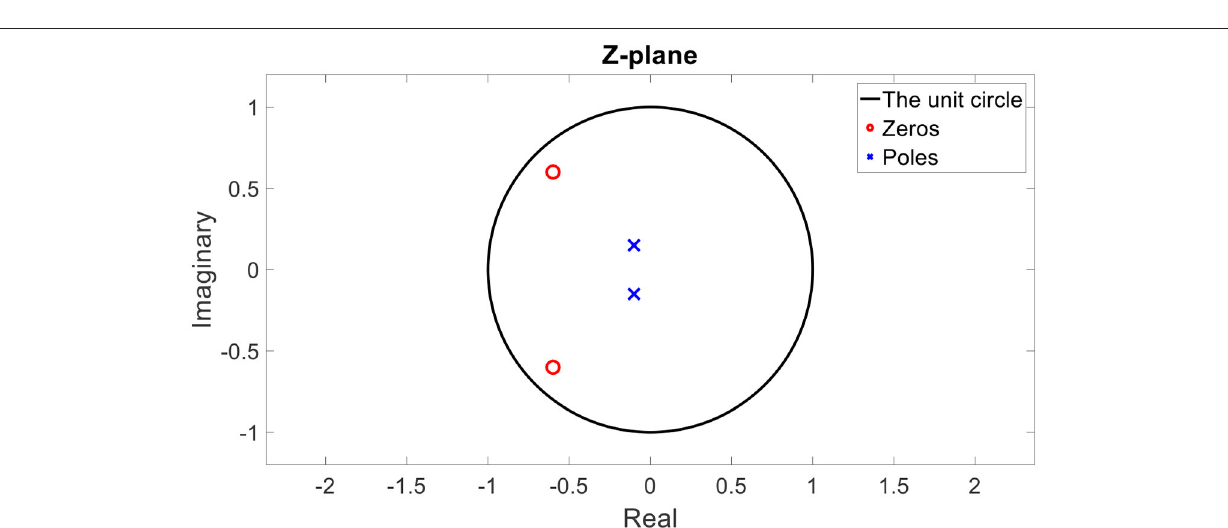
Frontiers in Artificial Intelligence |